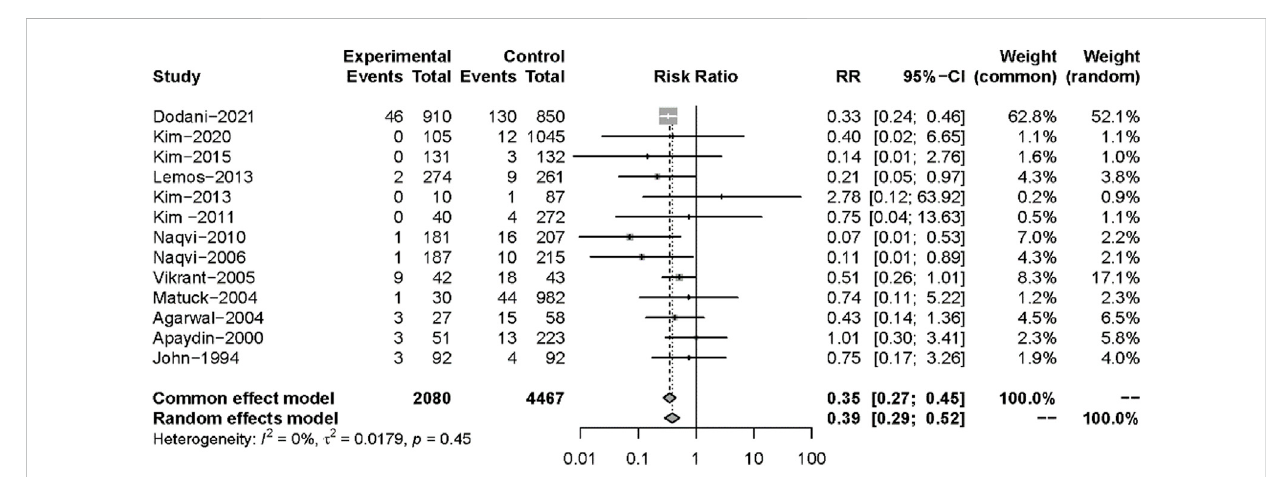
FIGURE 3 Forest plot for outcomes of active TB comparing isoniazid versus no